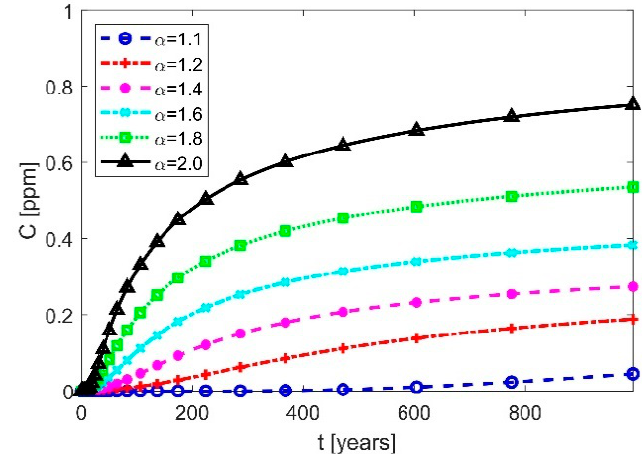
Figure 5. Time history of radionuclides at a reference node.